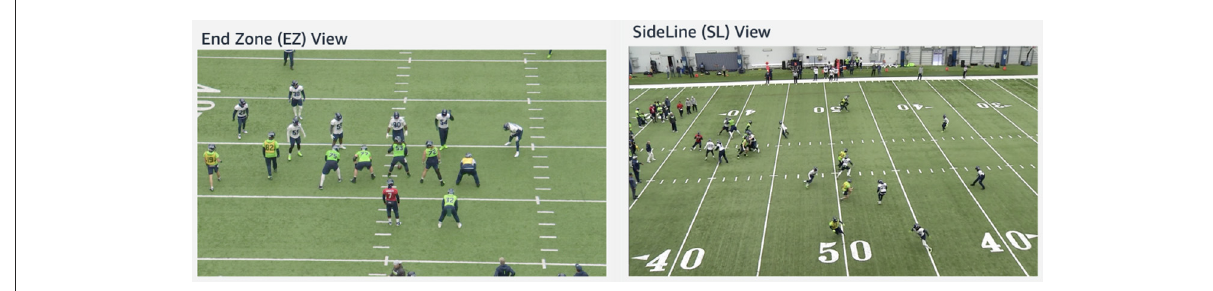
FIGURE3 Examples of frames obtained from the two different angles from the training videos. Left, is the endzone view of the players. Right, is the sideline view which offers better visibility into jersey numbers. Within a play, we can find players, observers with/without football